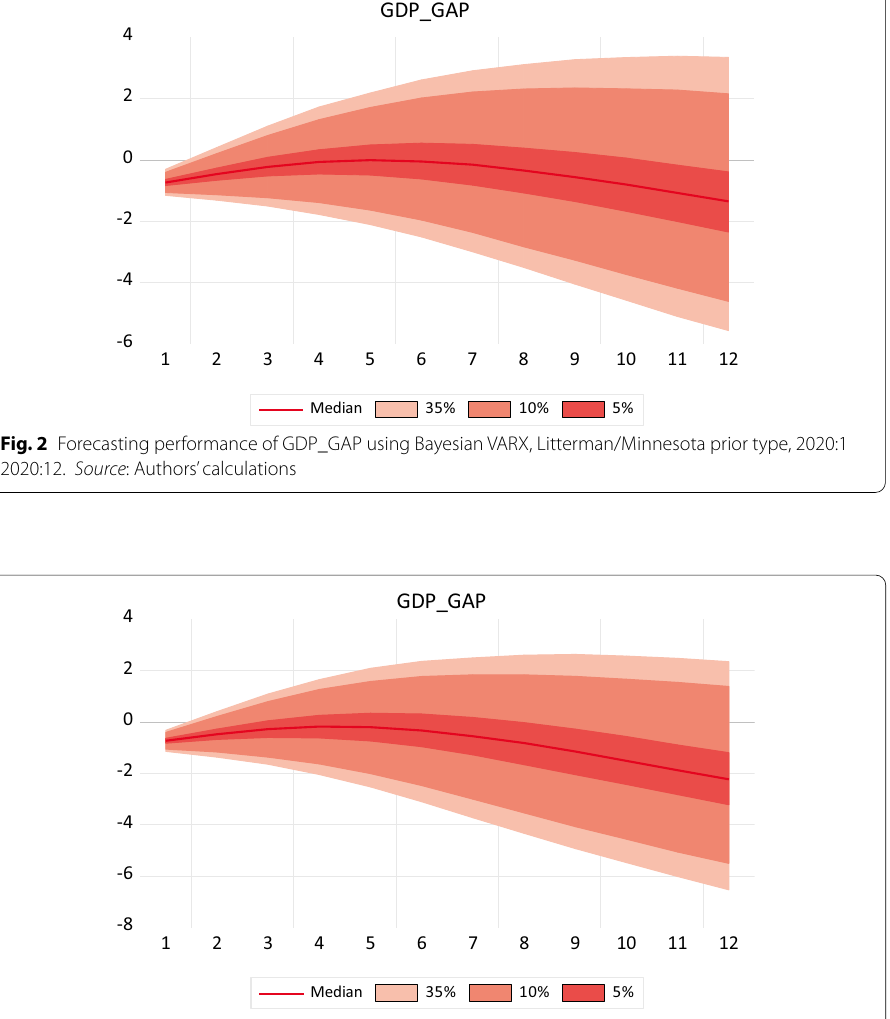
Fig. 3 Forecasting performance of GDP_GAP using Bayesian VARX, Sims-Zha (normal-Wishart) prior type, 2020:1 2020:12. Source : Authors’